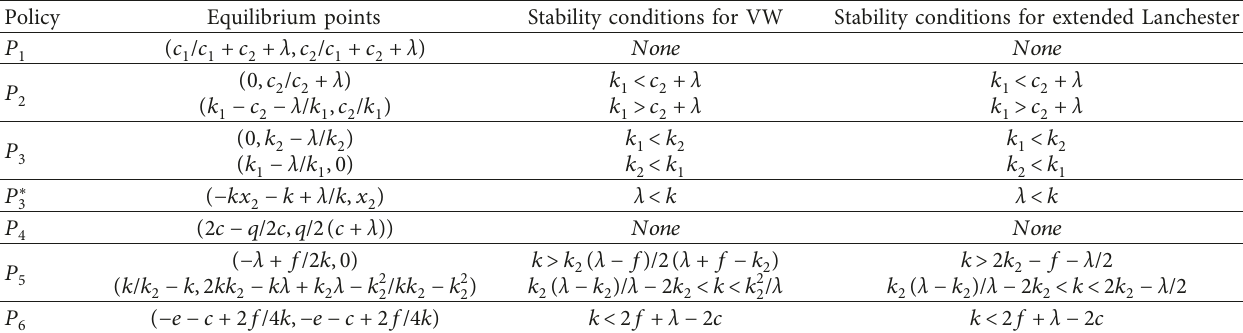
Table 3: Conditions on the advertising policy parameters to guarantee stability of the equilibrium points. The expression “ None ” indicates that there is no restriction on the values of advertising policies parameters to guarantee the condition of stability of the equilibria of both models (cf. Theorem